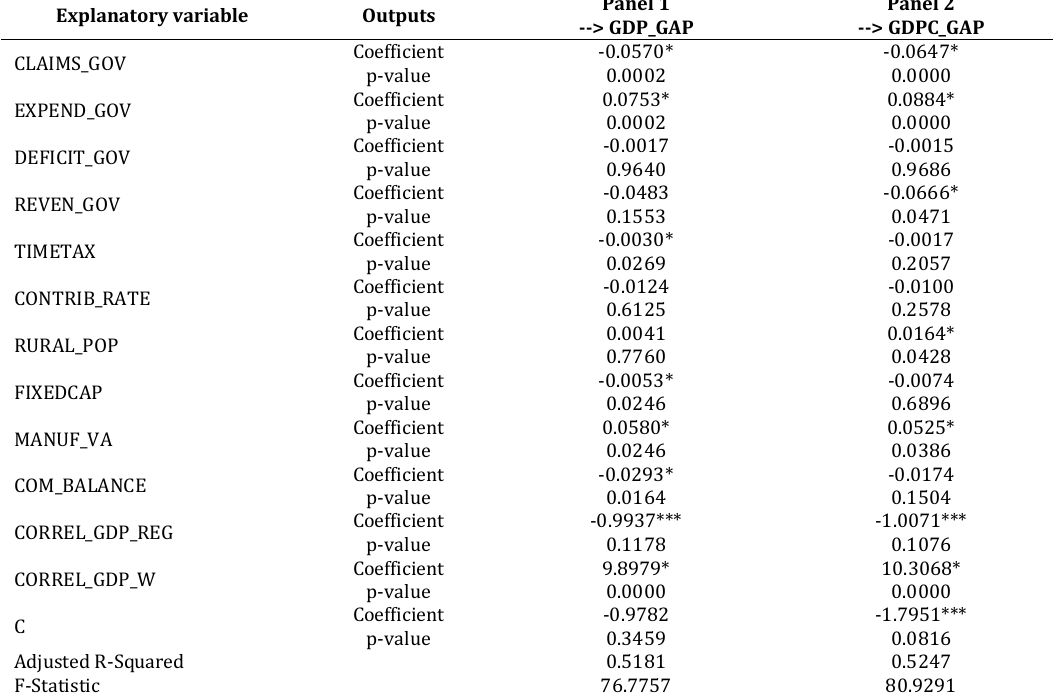
Table 1: Unrestricted model outputs